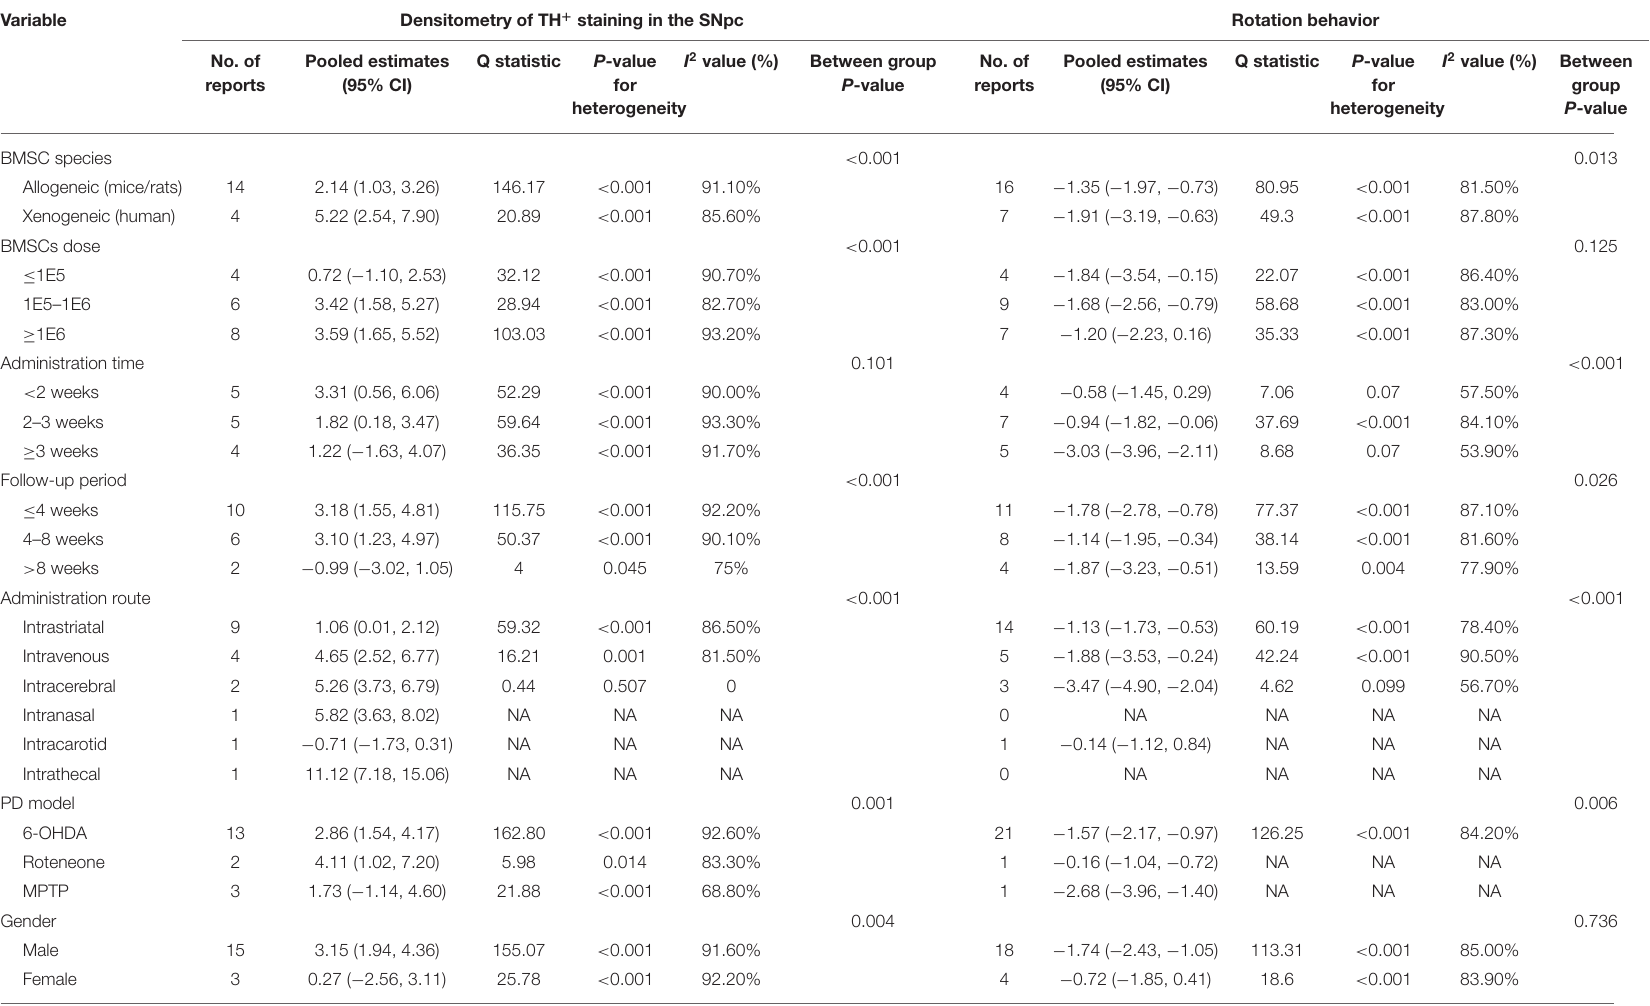
TABLE 2 | Subgroup analysis of rotational behavior and densitometry of TH + staining in animal models of Parkinson’s disease associated with BMSC therapy.